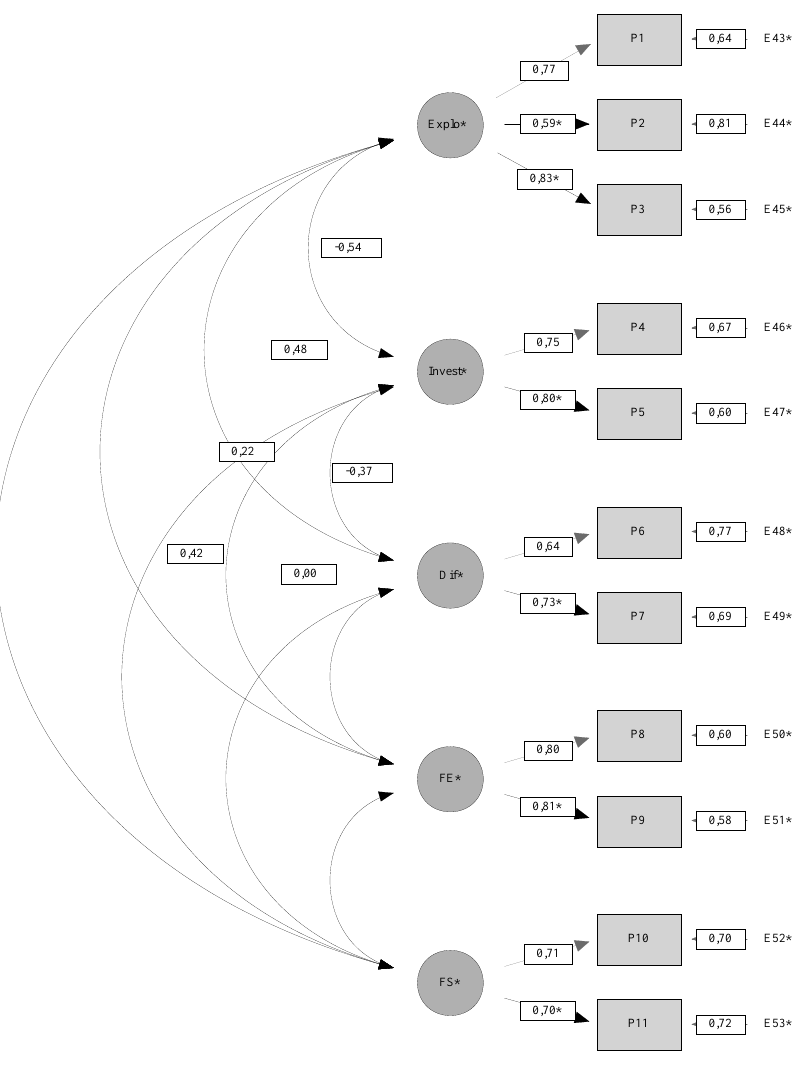
Figura 1. Modelo de análise fatorial confi rmatória da Escala de Exploração e Investimento Vocacional – EEIV. Nota . *Parâmetro